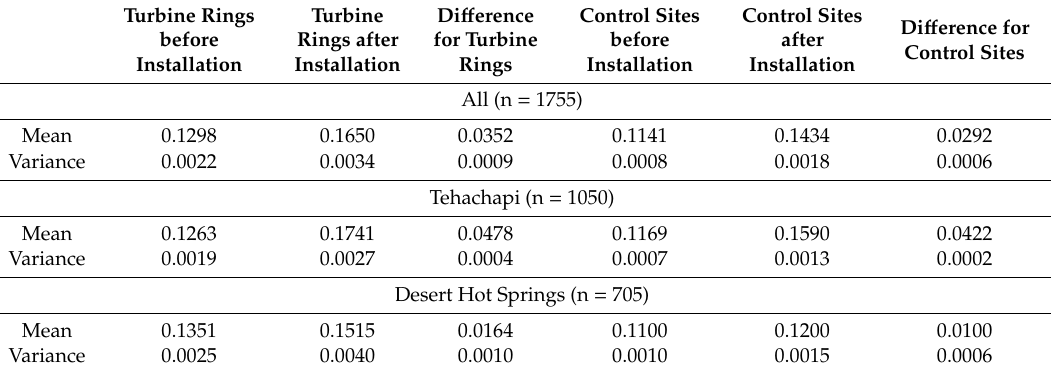
Table 1. Mean and variance of ESI values calculated for turbine rings and control sites before and after the installation